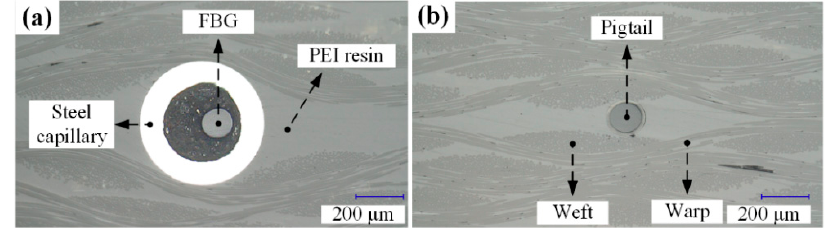
Figure 7. Cross section of the ( a ) head and ( b ) pigtail of the embedded EFBG sensor.